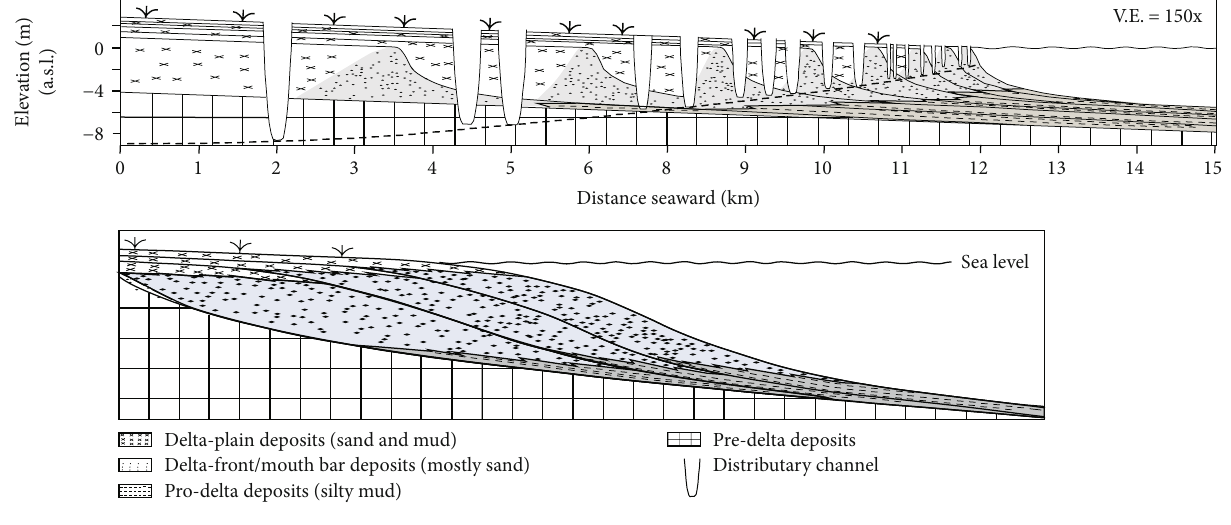
Figure 5: Pro fi les of topset and foreset dominated deltas (Edmonds,